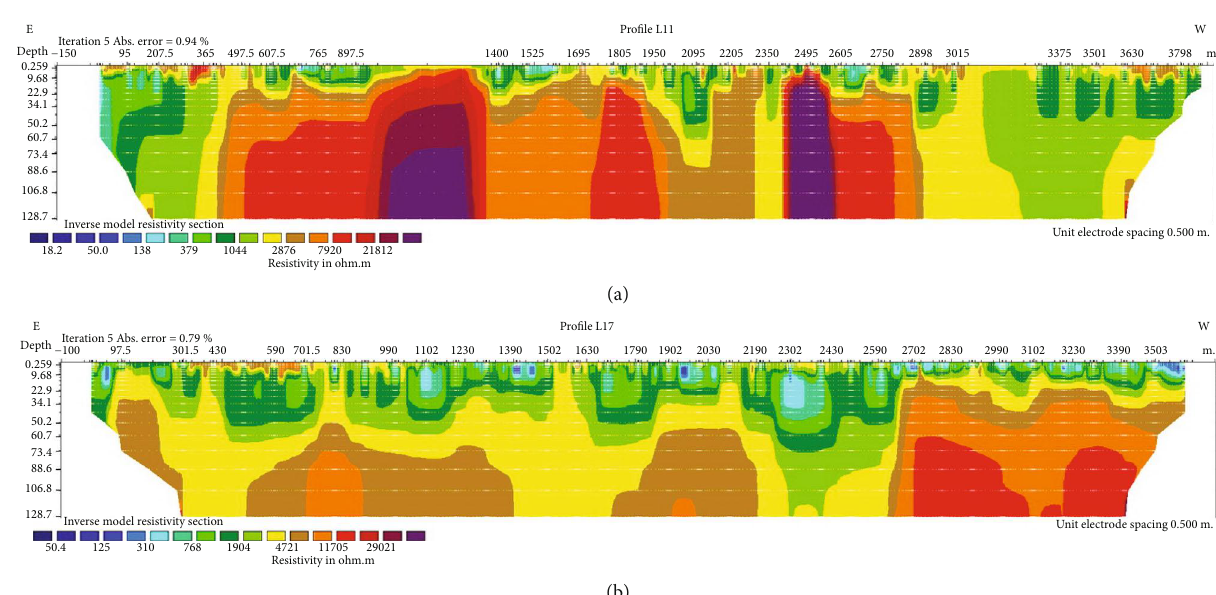
Figure 17: (a) Geolectrical pseudosection of pro fi le L11 (Colomine area 1). (b) Geolectrical pseudosection of pro fi le L17 (Colomine area